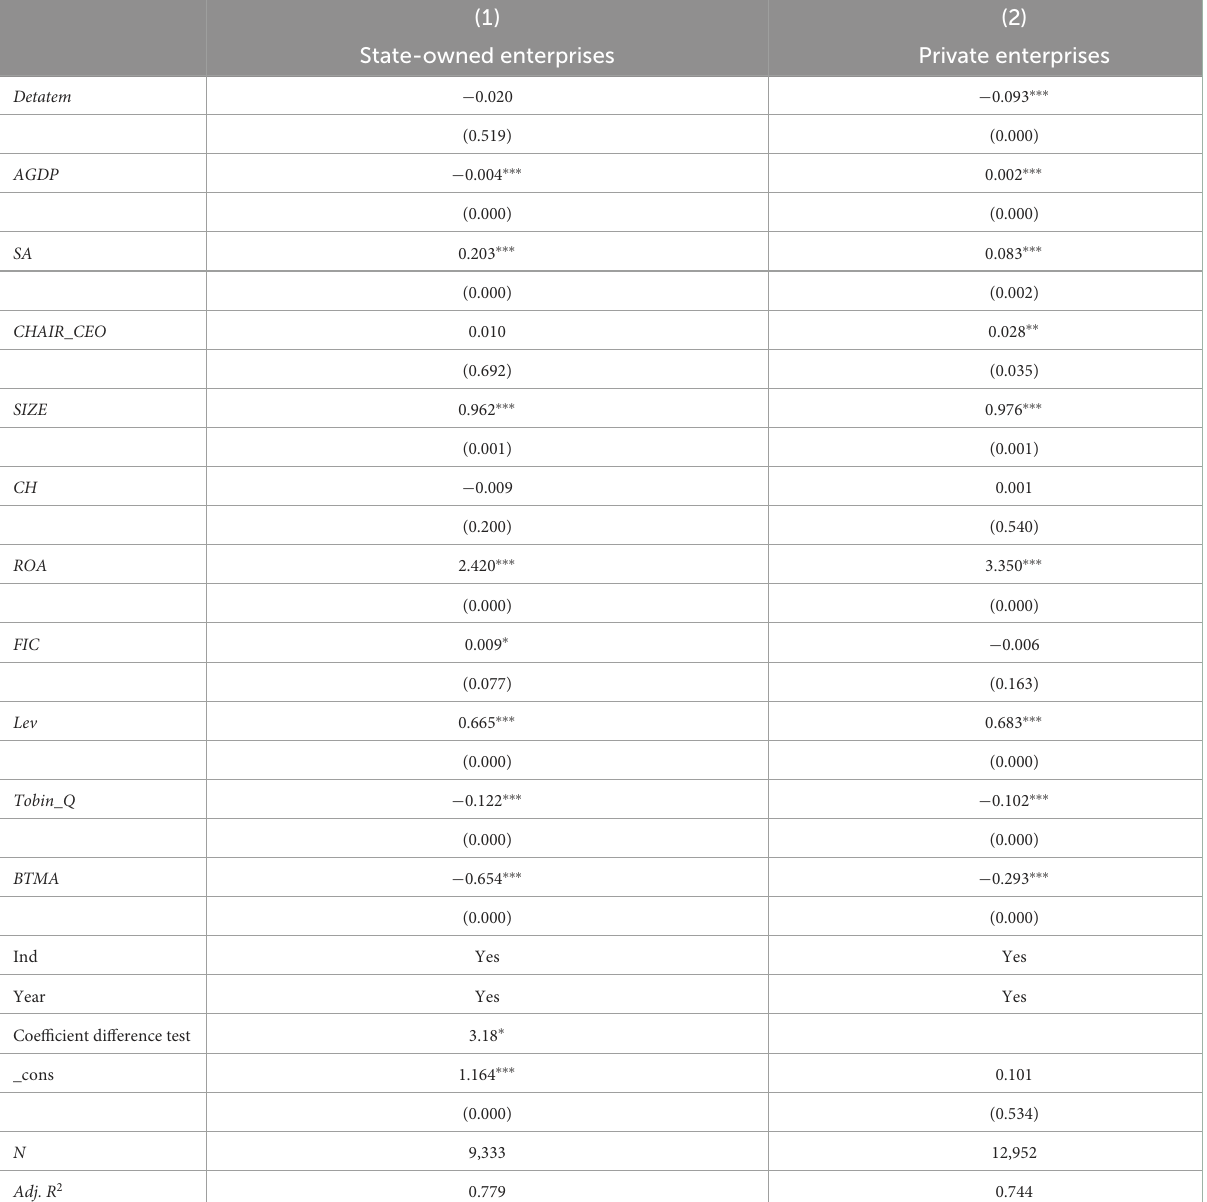
TABLE 9 Climate change, ownership, and sales